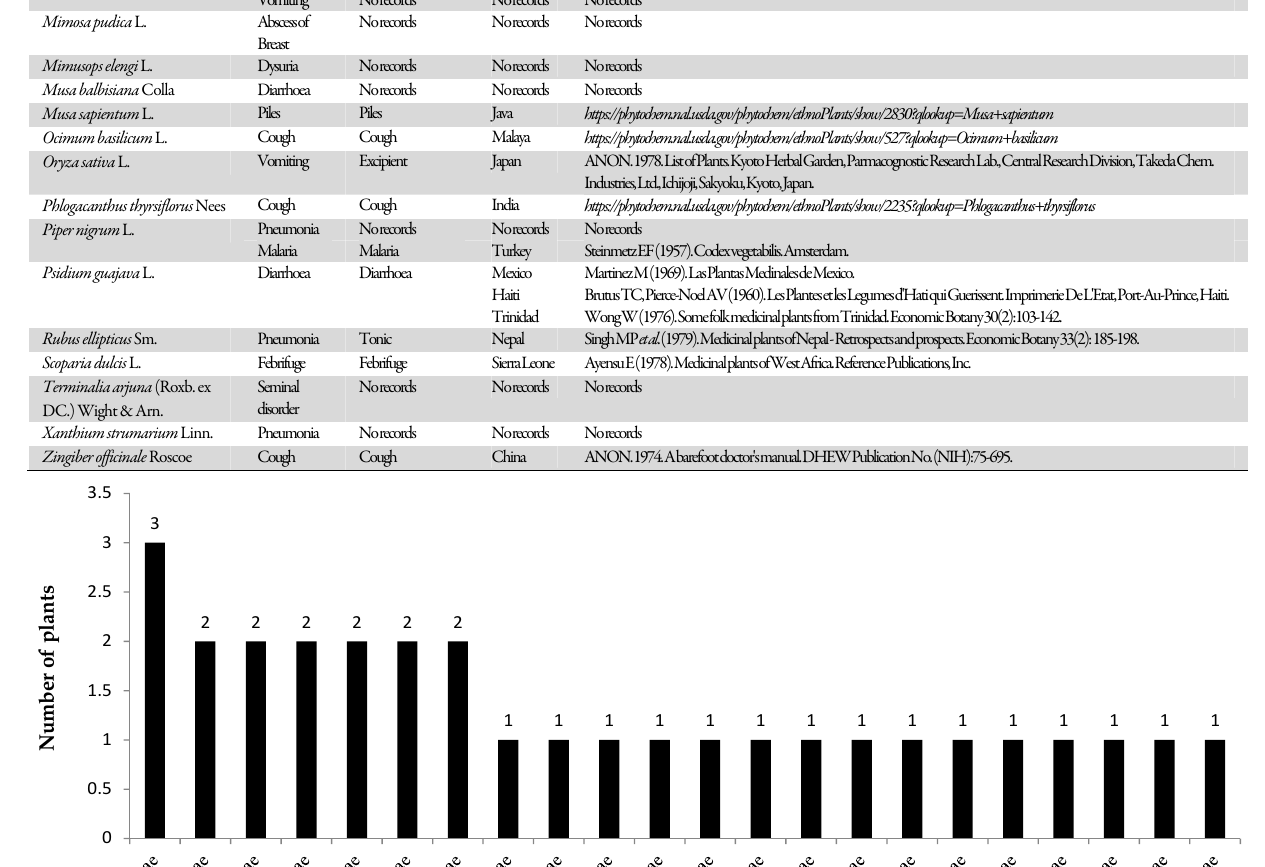
Hydrocotyle javanica Thunb. Standl.